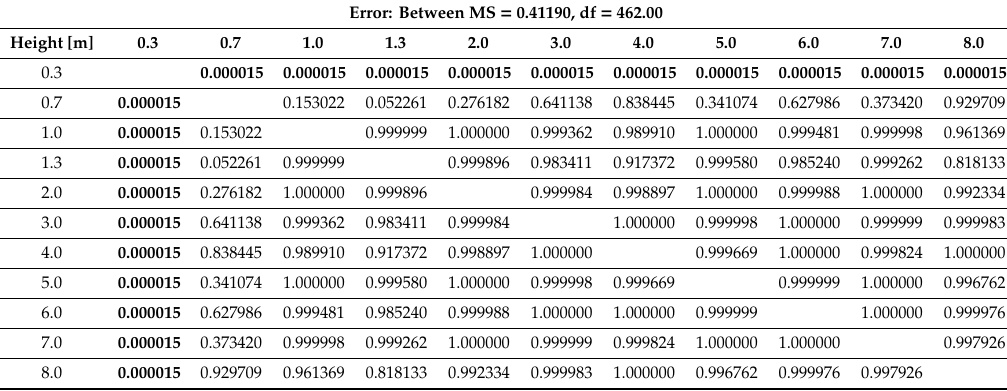
Table A2. Results of one-way ANOVA post hoc Tukey HSD test for TLS